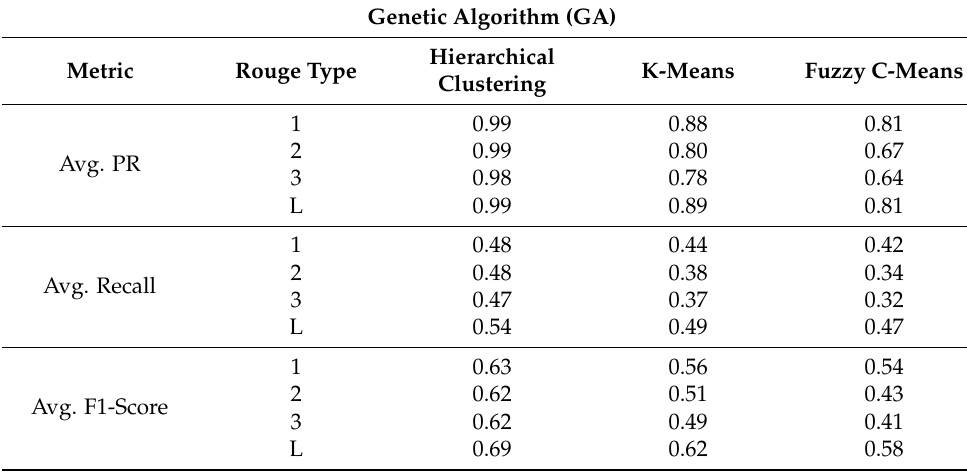
Table 1. Genetic Algorithm (GA) with clustering